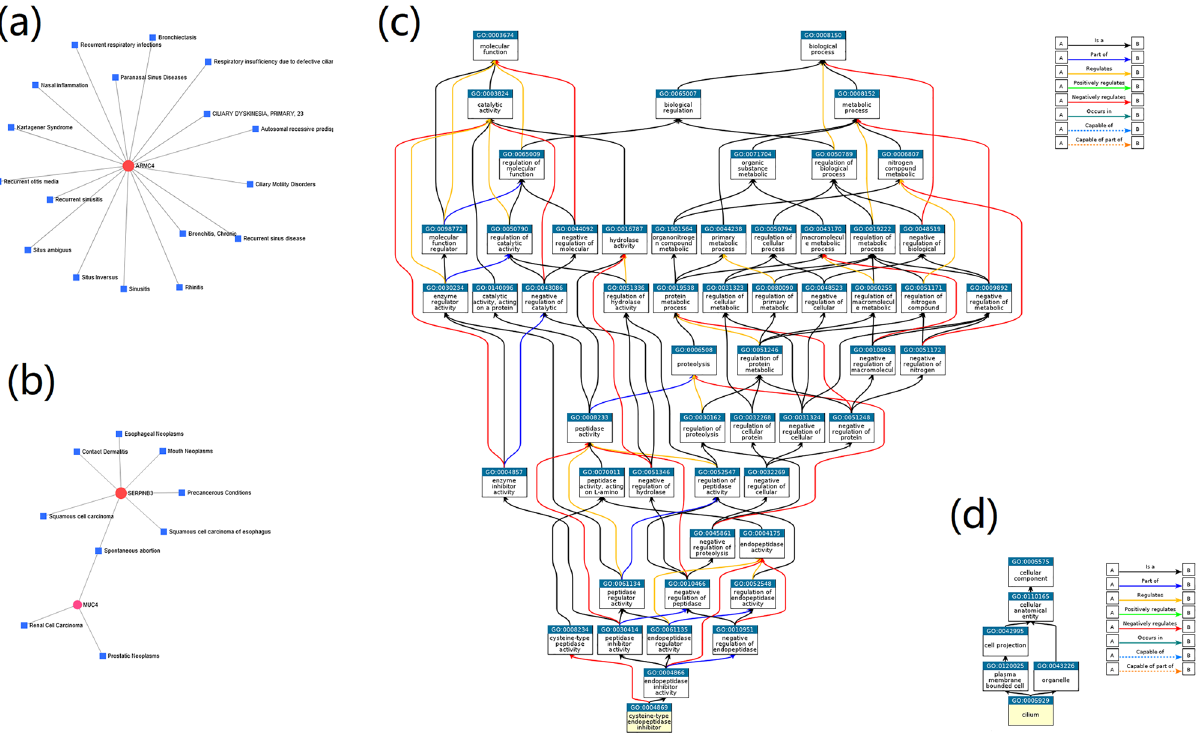
Figure 5. Hubs of DEGs with strong association with diseases and the process-focused annotation. The largest ( a ) and second largest ( b ) sub-networks. The red circle area represents the most significantly disease-associated genes (hub genes), and the blue square area represents genes related to the hub genes. QuickGO term (GO: 0,004,869 ‘cysteine-type endopeptidase inhibitor activity’( c ) and GO: 0,005,929 ‘cilium’ ( d )) ancestor chart. Currently, eight relationship types are described in Huntley 45 . Briefly, ‘is a’ presents a subclass of its parent, ‘part of’ stands for part of the parent term, ‘regulates’ is a process that modulates its parent process, and ‘positively regulates’ and ‘negatively regulates’ enhance and decrease the modulation of a parent process term, respectively. The fig ( a , b ) were drawn using online tool NetWorkAnalyst online software (https:// www. netwo rkana lyst. ca/, 3.0), and fig ( c , d ) were drawn using online tool Venny QuickGO (https:// www. ebi. ac. uk/ Quick